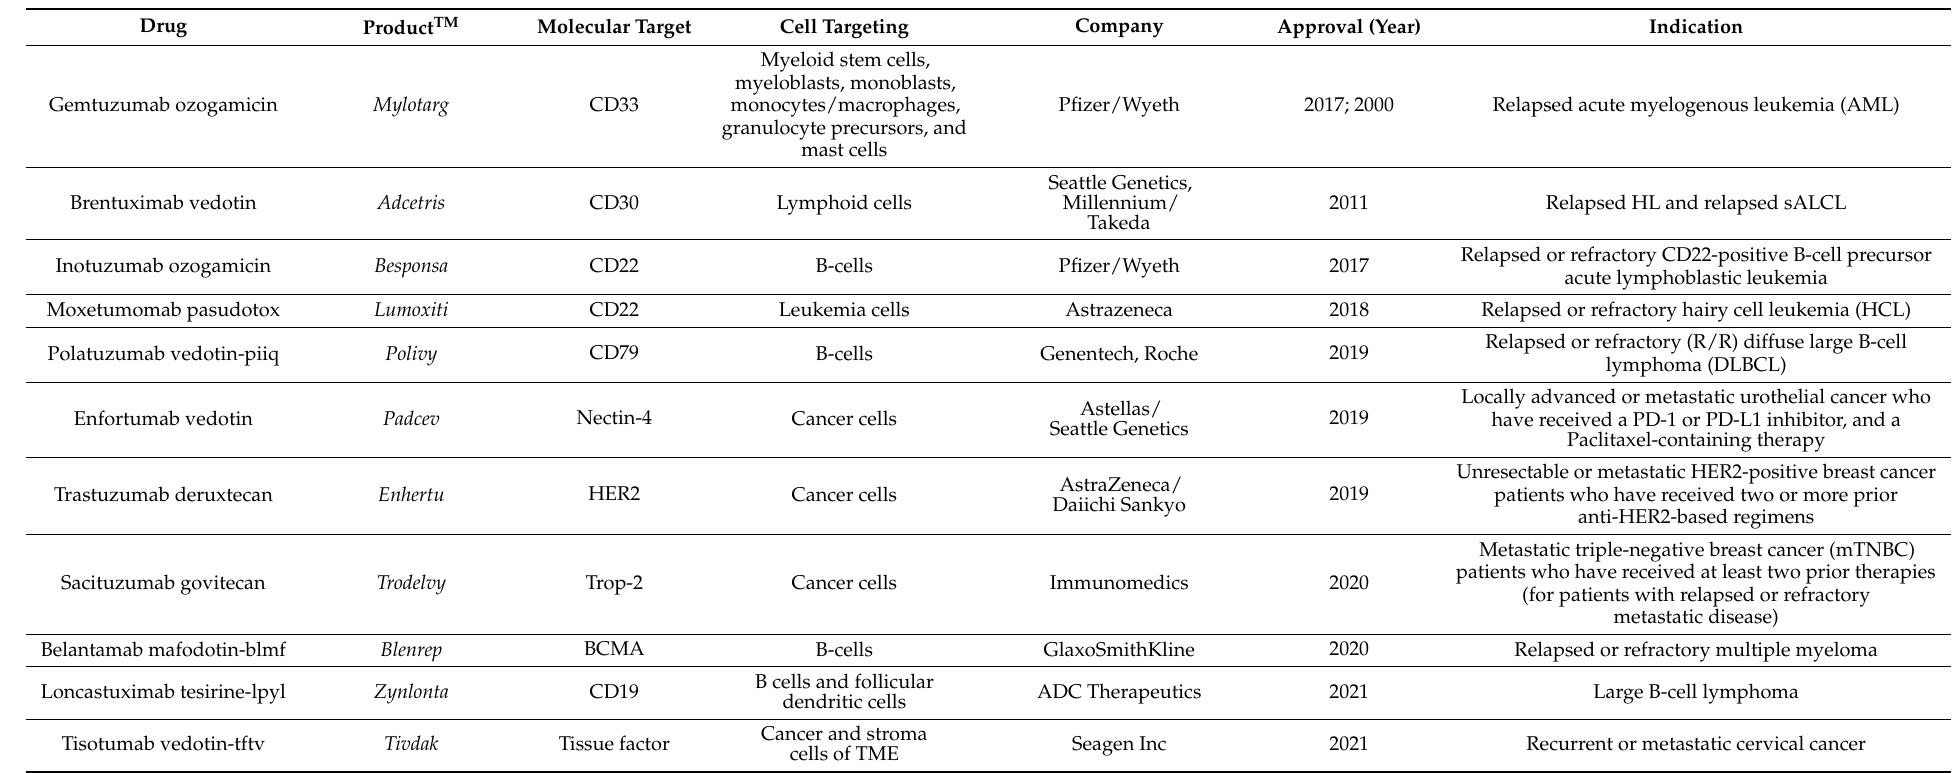
Table 2. The approved antibody drug conjugates for cancer